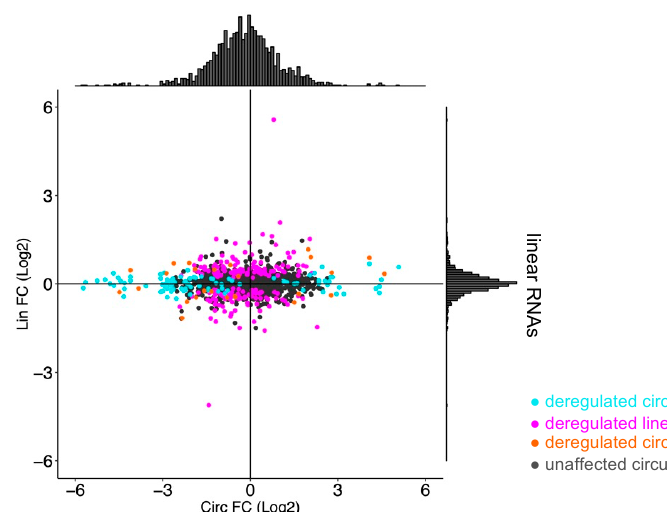
● deregulated circular RNAs ● deregulated linear RNAs ● deregulated circular and linear RNAs ● unaffected circular and linear RNAs